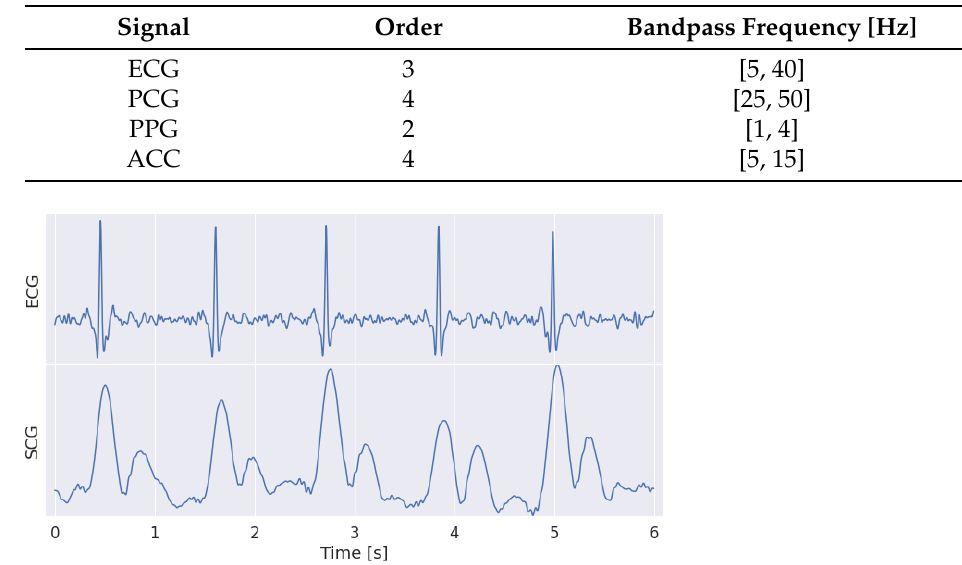
Table 1. Bandpass filter parameters applied to the signal of interest. The accelerometer (ACC) parameters were applied separately to all the three components ( x , y , and z ).